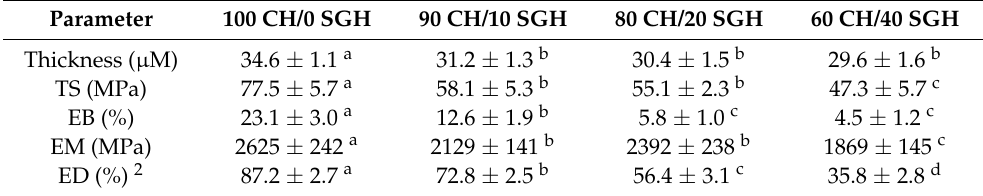
Table 3. Thickness, tensile strength (TS), elongation at break (EB), elastic modulus (EM), and enzymatic degradation (ED) of chitosan (CH) with squid gelatin hydrolysate (SGH) films 1 . Parameter